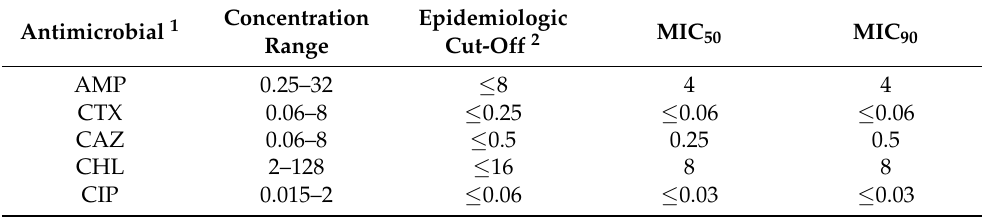
Table 1. Antimicrobials tested, concentration range, reference concentrations and distribution of MIC values (mg L − 1 ) among E. coli isolates ( n = 20) obtained from biofilms after antibiotic exposure. Antimicrobial